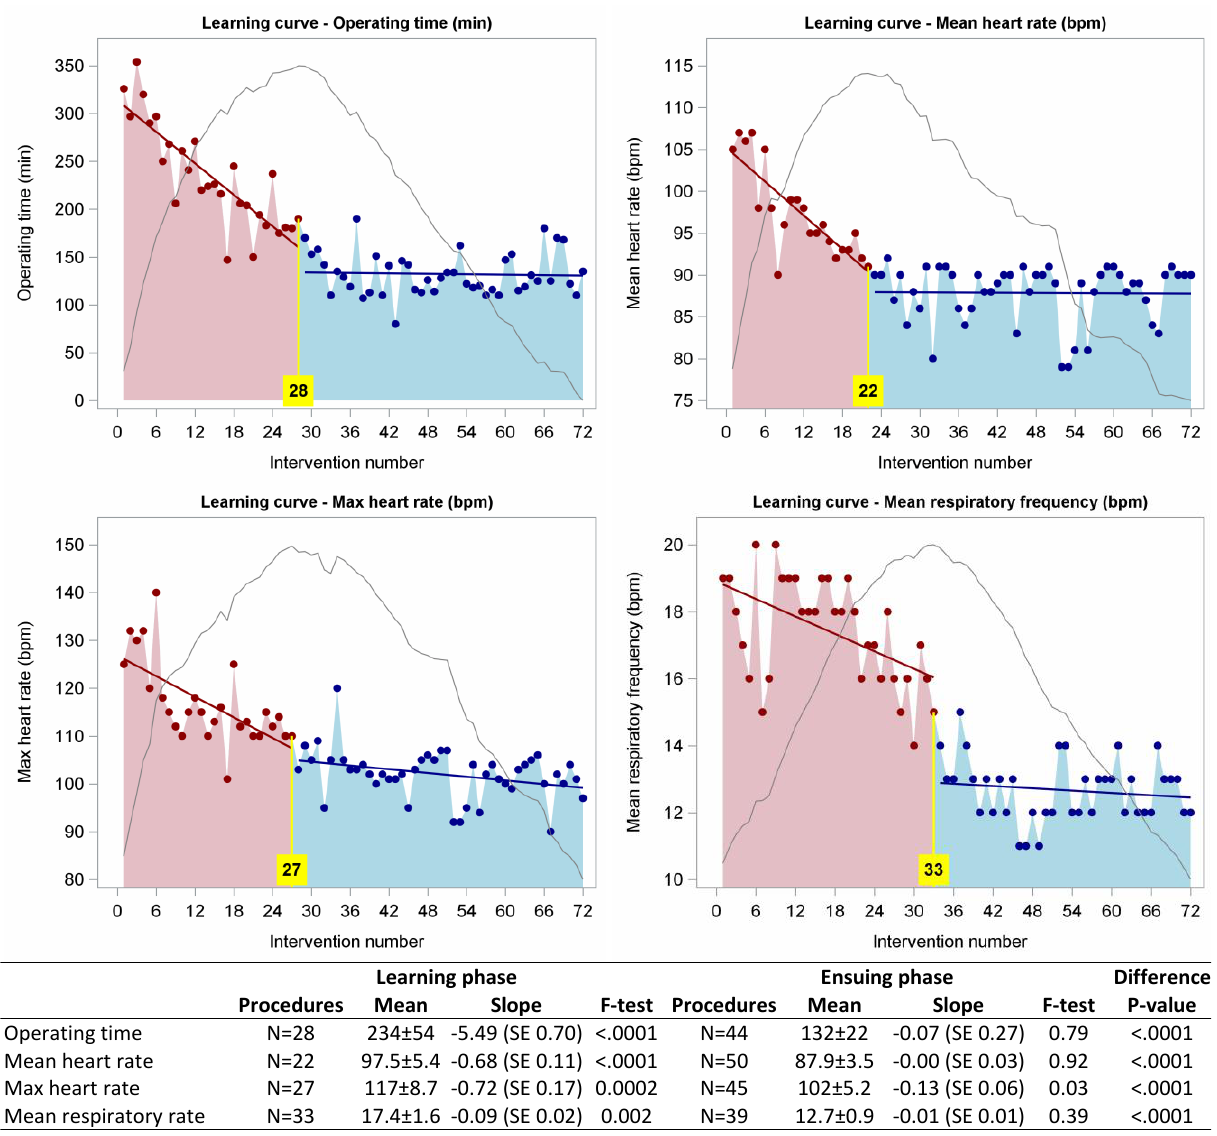
Figure 3. Learning curves for robotic-assisted lobectomy concerning operative time, mean heart rate, max heart rate and mean respiratory frequency. The grey lines represent the cumulative sum control charts, and the value in the yellow box the number of procedures at the graphical peak, representing the end of the learning phase. The regression lines highlight trends in the training phase (red) and in the ensuing phase